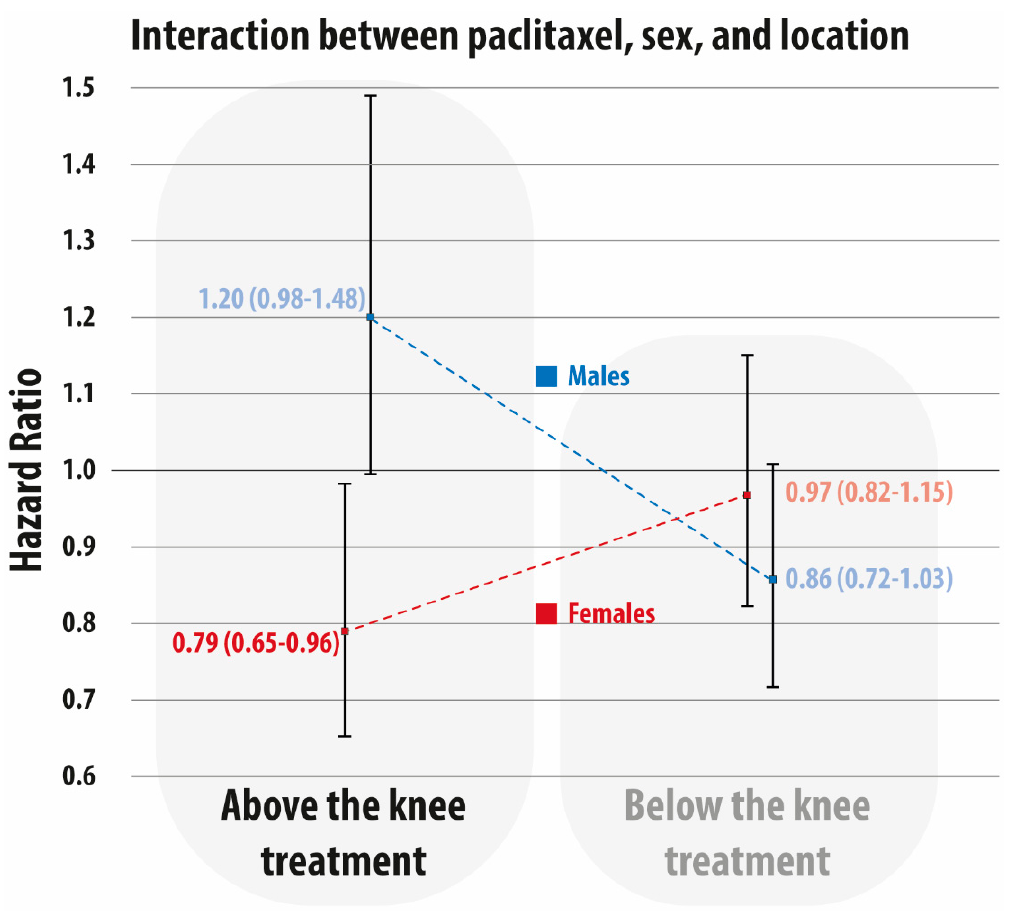
Figure 3. Interaction between paclitaxel exposure (yes vs. no), sex (female vs. male), and level (above-the-knee treatment vs. below-the-knee treatment). Hazard ratio and 95% confidence interval are in red for females and in blue for males.